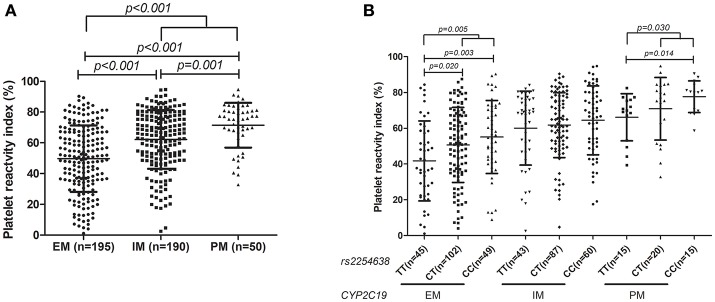
Association of distribution of CYP2C19 metabolic phenotype with PRI (A) and the influence of rs2254638 polymorphism on PRI in different CYP2C19 metabolic phenotype (B).